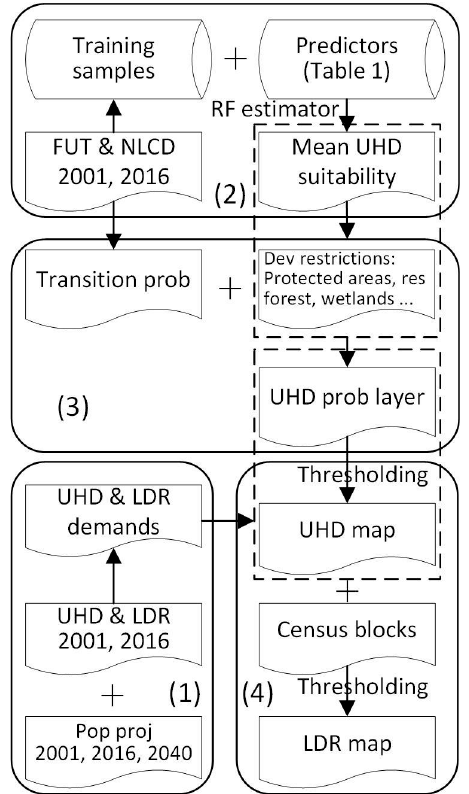
Figure 1. Framework of our modeling methods. ( 1 ) Projecting urban demands, ( 2 ) calculating development suitability, ( 3 ) creating urban development probability, and ( 4 ) generating binary UHD and LDR projections. UHD: urban and highly developed; LDR: low-density residential. Datasets used across modeling steps are highlighted under dotted frames.